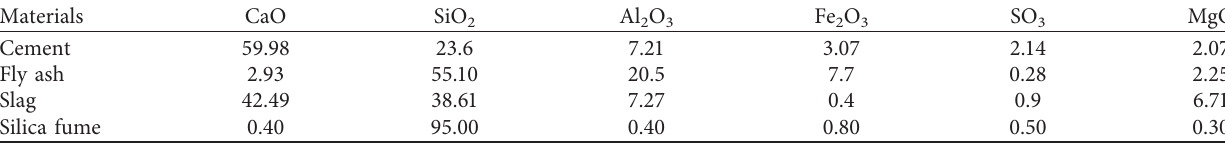
Table 1: Main chemical composition of cementitious material (mass